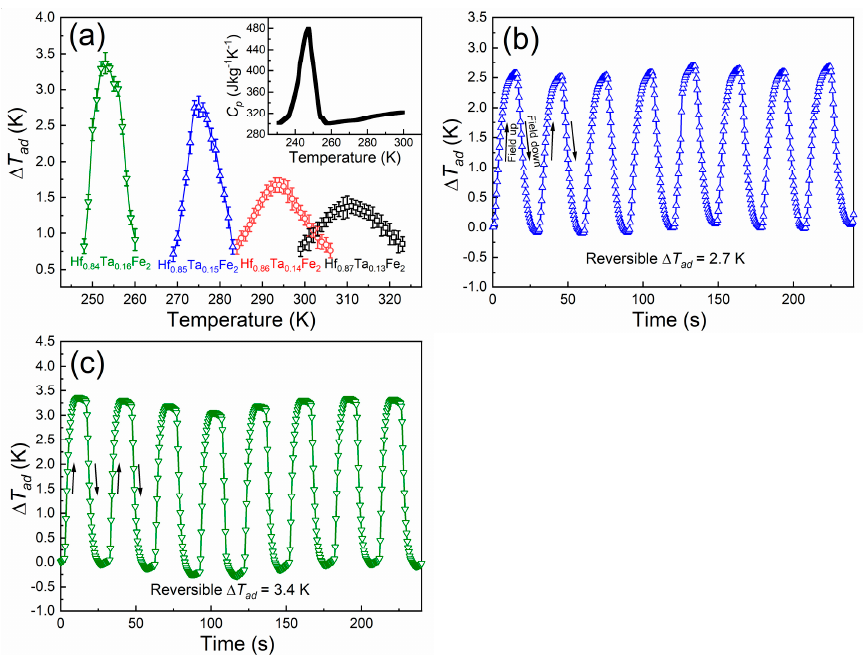
Figure 7. ( a ) Directly measured temperature dependence of Δ T ad curve for Hf 1- x Ta x Fe 2 ( x = 0.13, 0.14, 0.15, 0.16) alloys under the field change of 1.5 T. The inset shows the specific heat capacity for the Hf 0.84 Ta 0.16 Fe 2 alloy. The cyclic adiabatic temperature change for ( b ) Hf 0.85 Ta 0.15 Fe 2 alloy at 275 K and ( c ) Hf 0.84 Ta 0.16 Fe 2 alloy at 253 K. Table 1. Comparisons on the maximum reversible adiabatic temperature changes of some typical magnetocaloric materials reported in the literatures.